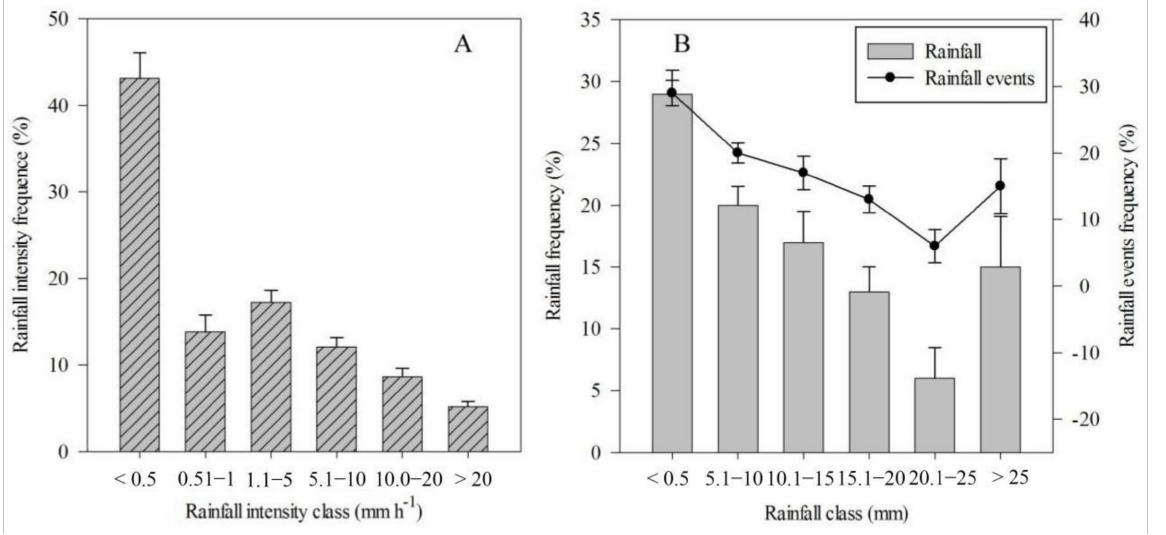
Figure 2. The distributions of the rainfall intensity, rainfall, and rainfall events from 1 May to 30 September 2014–2018. ( A ), the frequency of different rainfall intensity classes; ( B ), the frequency of rainfall events and rainfall in different rainfall classes.